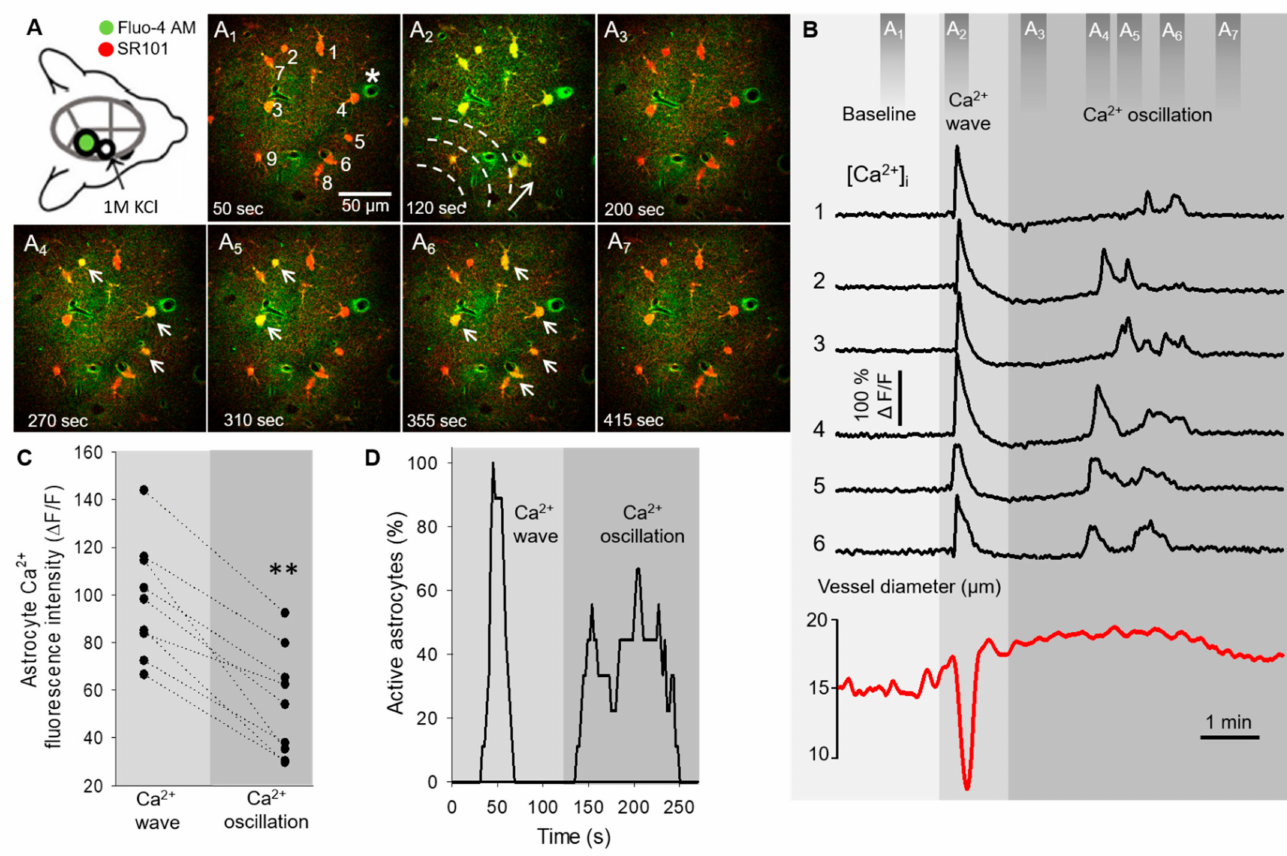
Figure 1. Astrocyte Ca 2+ dynamics during spreading depolarization (SD) in the mouse somatosensory cortex. ( A ) Schematic illustration of the closed cranial window preparation indicates the position of the imaging site (green). SD events were triggered by topical application of KCl in a smaller rostral open craniotomy (open circle). Images ( A 1–7 ) demonstrate astrocyte Ca 2+ changes (Fluo-4 AM, green) associated with SD. Astrocytes (numbered 1–6 on A 1 ) were selectively labeled by SR101 (red). Dashed lines and arrow ( A 2 ) denote the direction of SD propagation; white arrows are pointing at astrocyte somata displaying Ca 2+ oscillations ( A 4–6 ). ( B ) Astrocyte Ca 2+ changes (i.e., wave and oscillations) extracted from regions of interests (numbered 1–6 in A 1 ) coincide with arteriole diameter changes (labeled with * in A 1 ) during SD. Dark grey bars (top) indicate time points of the corresponding images ( A 1–7 ). ( C ) Ladder plot shows the peak fluorescence maximum ( ∆ F/F) of Ca 2+ waves and subsequent oscillations derived from nine cells. ( D ) Percentage of astrocytes ( n = 9 in total) displaying Ca 2+ changes at each time point during acquisition. Ca 2+ events were defined as ∆ F/F ≥ 13% with respect to baseline fluorescence. Images were taken at a cortical depth of 55–75 µ m. Data are given as mean ± st.dev. Two-tailed paired t -test was used for statistical analysis with the level of significance set at p ** <